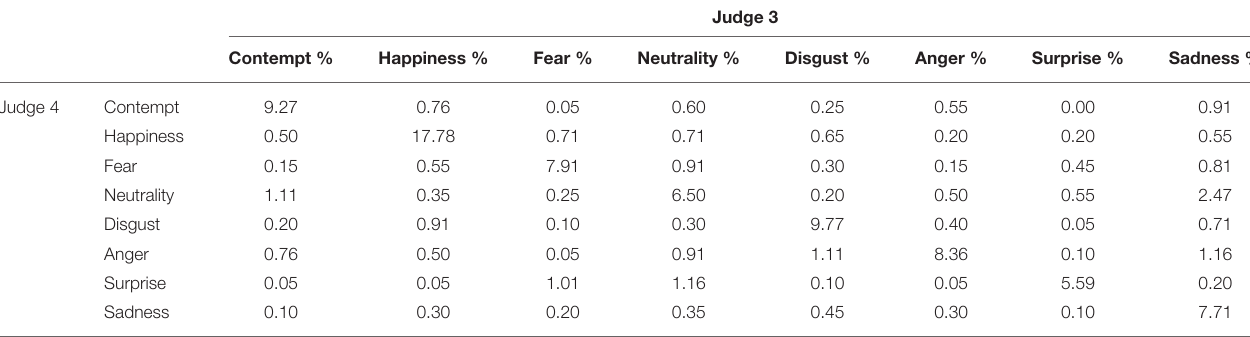
TABLE 4 | Validation of ChildEFES database.